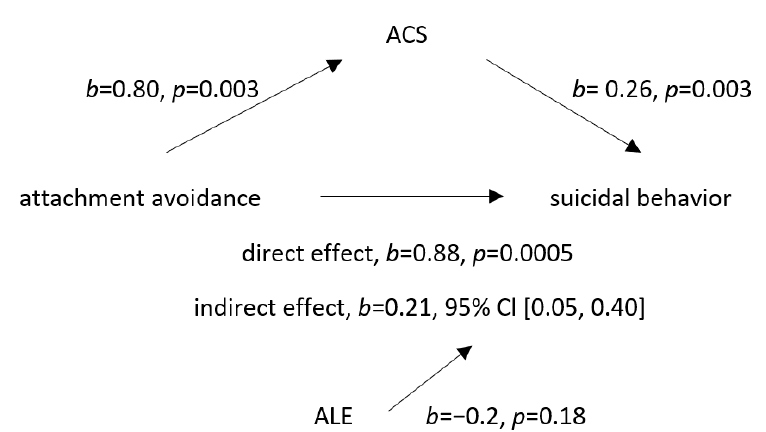
Figure 2. Mediation model with acquired capability for suicide (ACS) as the mediator of the association between attachment avoidance in relation to father and suicidal behavior. Adverse life experiences were included as a covariant. Legend : ACS—acquired capability for suicide, ALE— adverse life experience, direct effect—association between attachment avoidance and suicidal behavior, and indirect effect—association between attachment avoidance and suicidal behavior when ACS was added as the mediating variable.